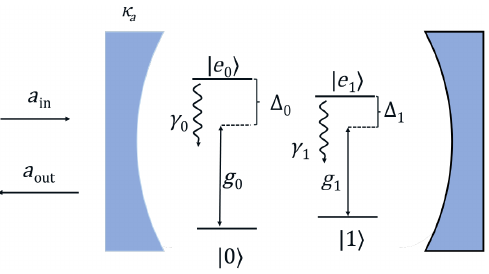
FIG. 6. The four-level system for spin-photon